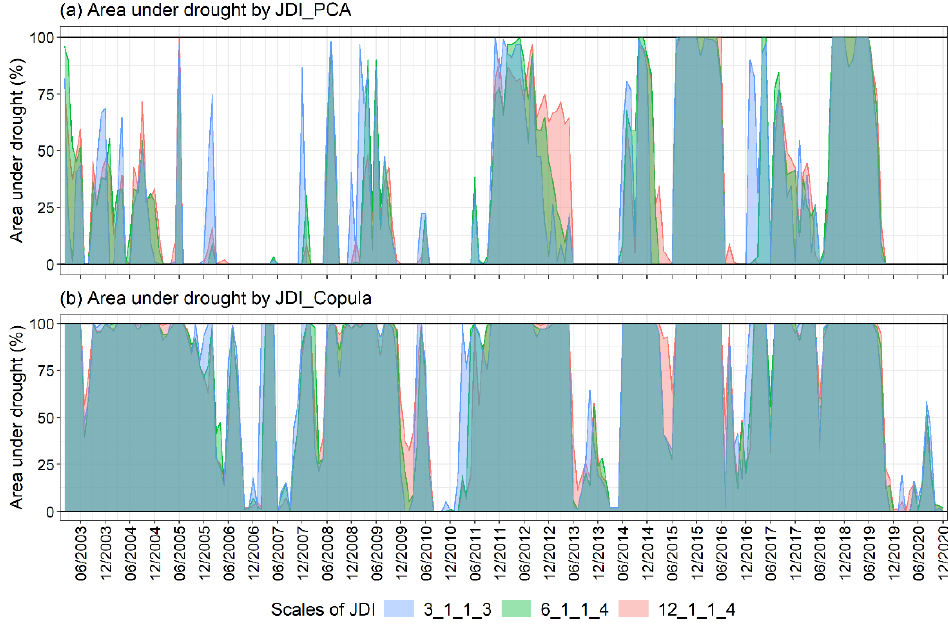
Figure 11. Area under drought for scales 3_1_1_3, 6_1_1_4 and 12_1_1_4 (representing scales for variables in order of the SPEI, SSI, SGI, and SRI) using ( a ) JDI_PCA and ( b ) JDI_Copula.